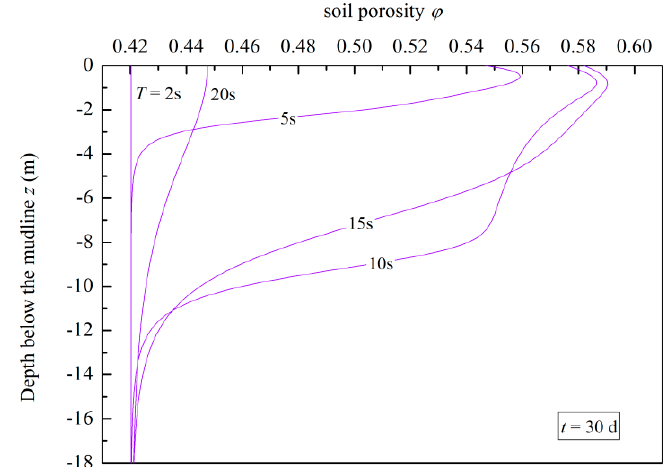
Figure 14. Variations of the soil porosity for different wave periods.